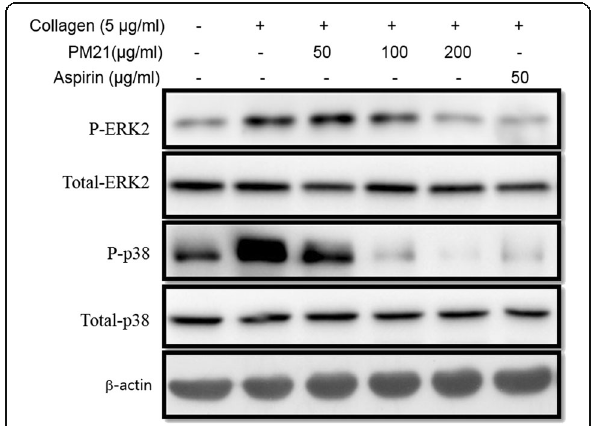
Fig. 5 Effects of PM21 on phosphorylation of ERK2 and p38. Rat platelets were pre-incubated for 2 min with PM21 (50, 100, 200 μ g/mL) or aspirin (50 μ g/mL), and stimulated with 5 μ g/mL collagen in the presence of Ca 2+ (1 mM) for 5 min. After termination of aggregation reactions, total cell proteins were extracted. The proteins were separated by SDS-PAGE and transferred on to nitrocellulose membranes. The membranes were then probed with antibodies against phospho-ERK2, ERK2, phospho-p38, p38 and β -actin. Antibody binding was visualized by chemiluminescence. All immunoblots are representatives of three or four independent experiments